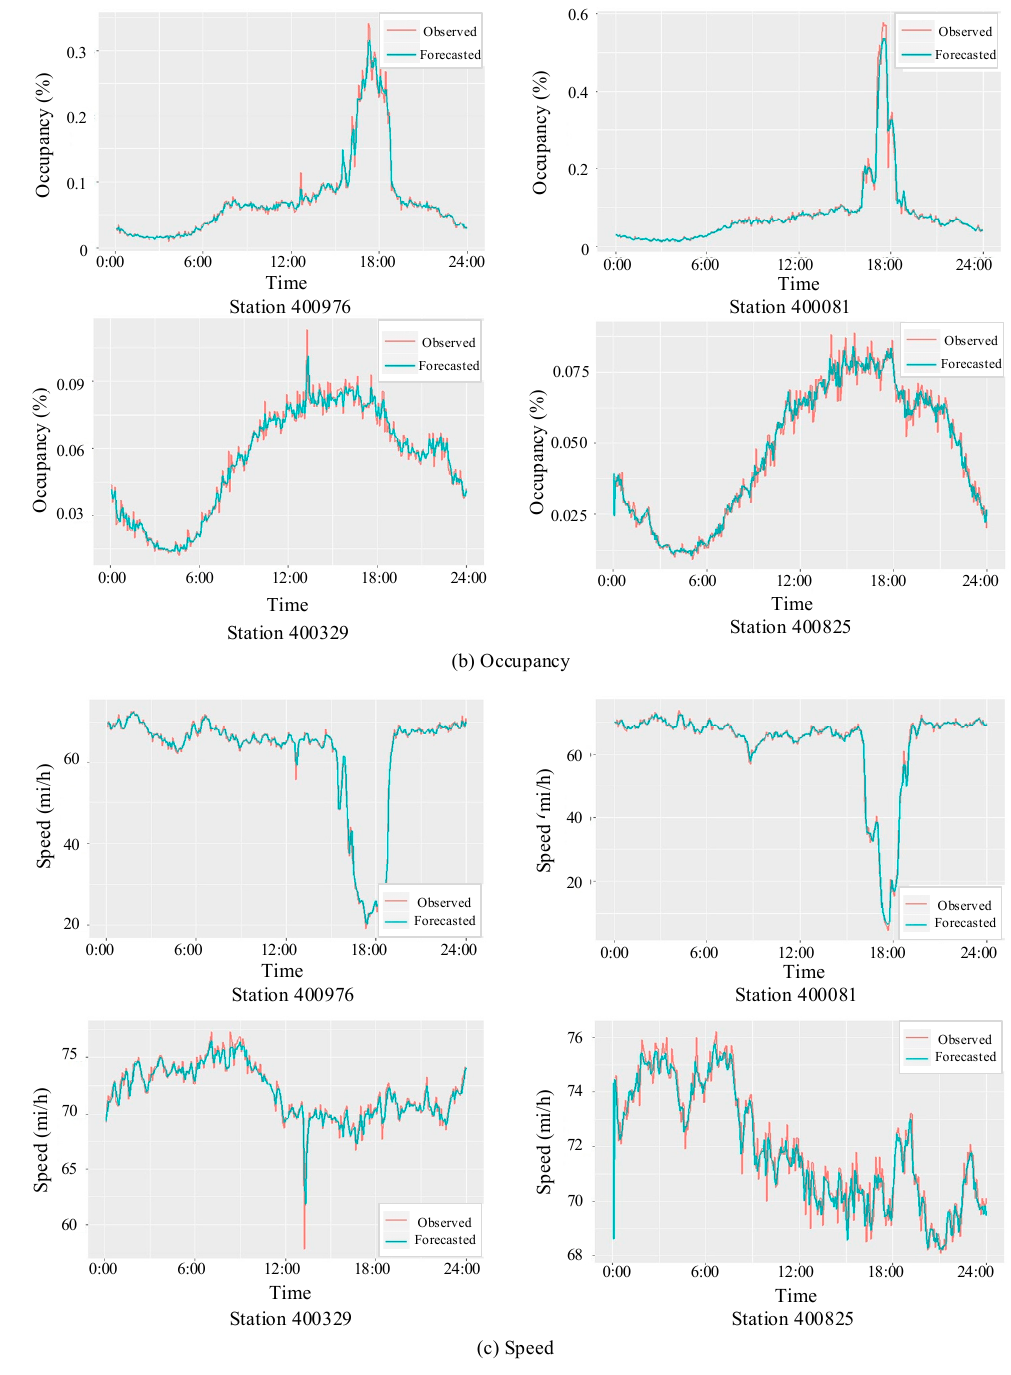
Figure 7. Comparisons between the observed and forecasted values of the three traffic flow measures.